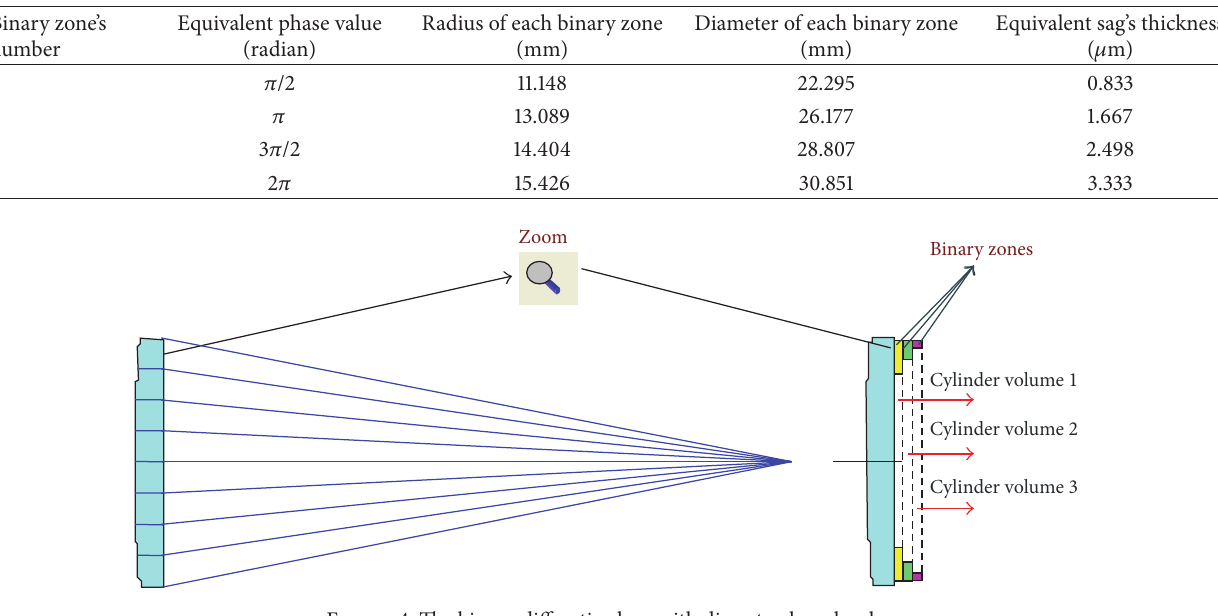
Figure 4: The binary diffractive lens with discrete phase levels.